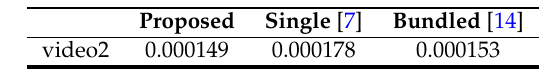
Table 4. Perspective distortion of the various video stabilization methods.